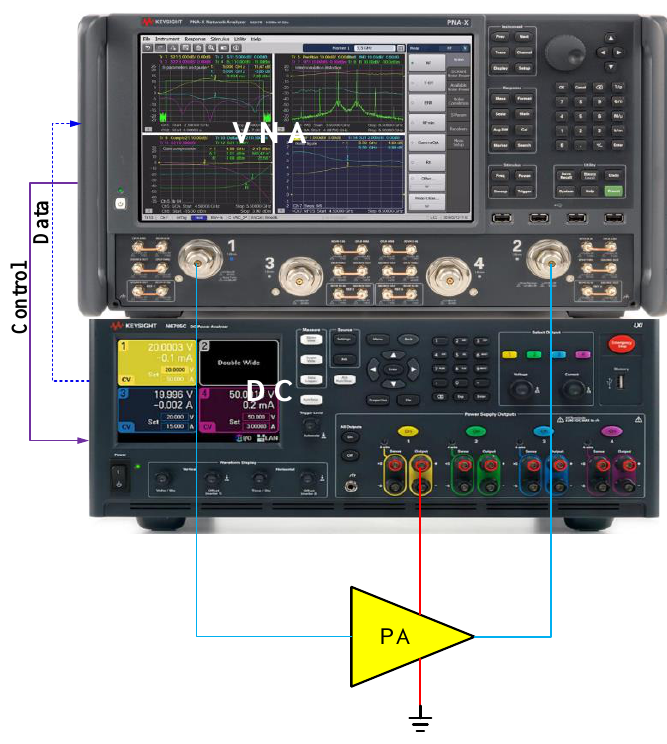
Figure 9. Accurate PAE test plan.